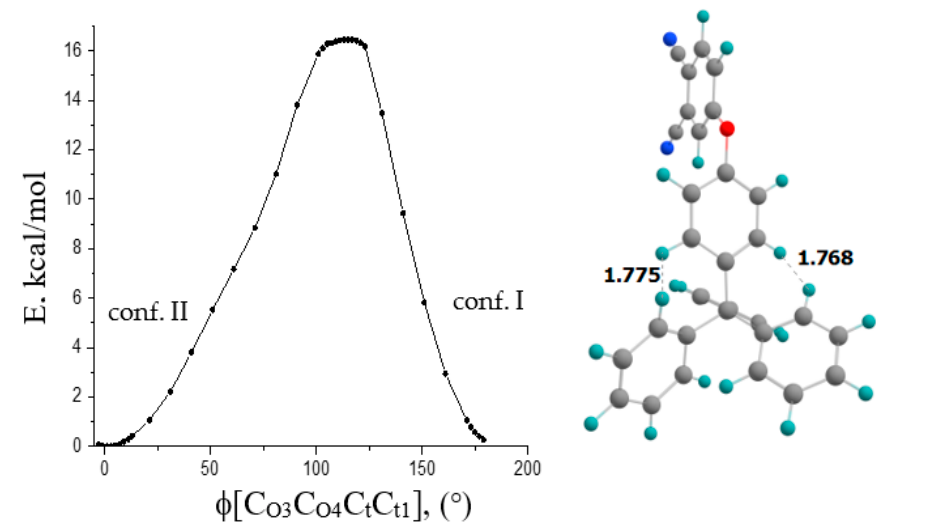
Figure 3. The potential function of internal rotation of O-PhN fragment around the C O1 -O bond. Structure TS I → II Structures of conformers I and II are shown in Figure 2.